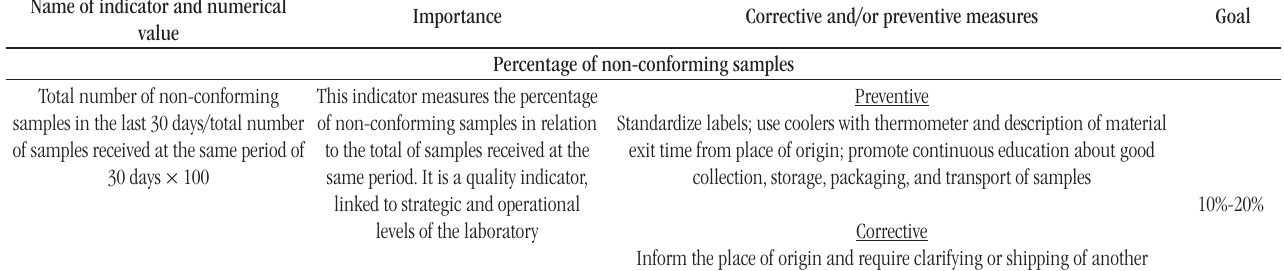
taBLE 1 − Definition and description of indicators relevant to all